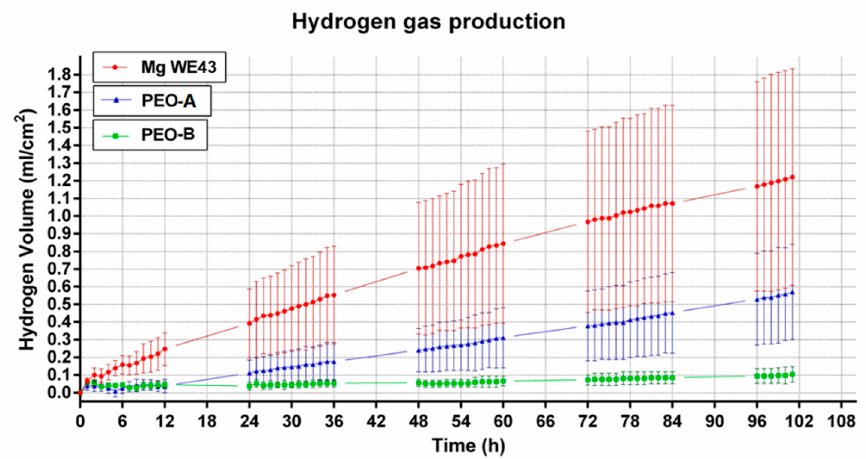
Figure 2. Comparison of the H 2 gas evolution of PEO-modified and unmodified test samples. The evolution of hydrogen gas varied less for the two PEO ceramiced samples compared to the untreated samples. PEO-B showed an almost linear curve shape and performed better in terms of degradation resistance than PEO-A.